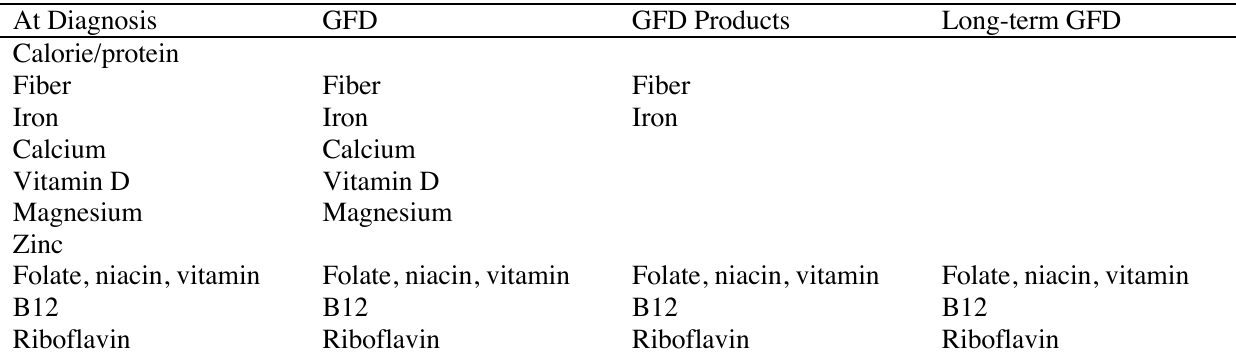
Table 1 . Common nutrient deficiencies in CD. 20 At